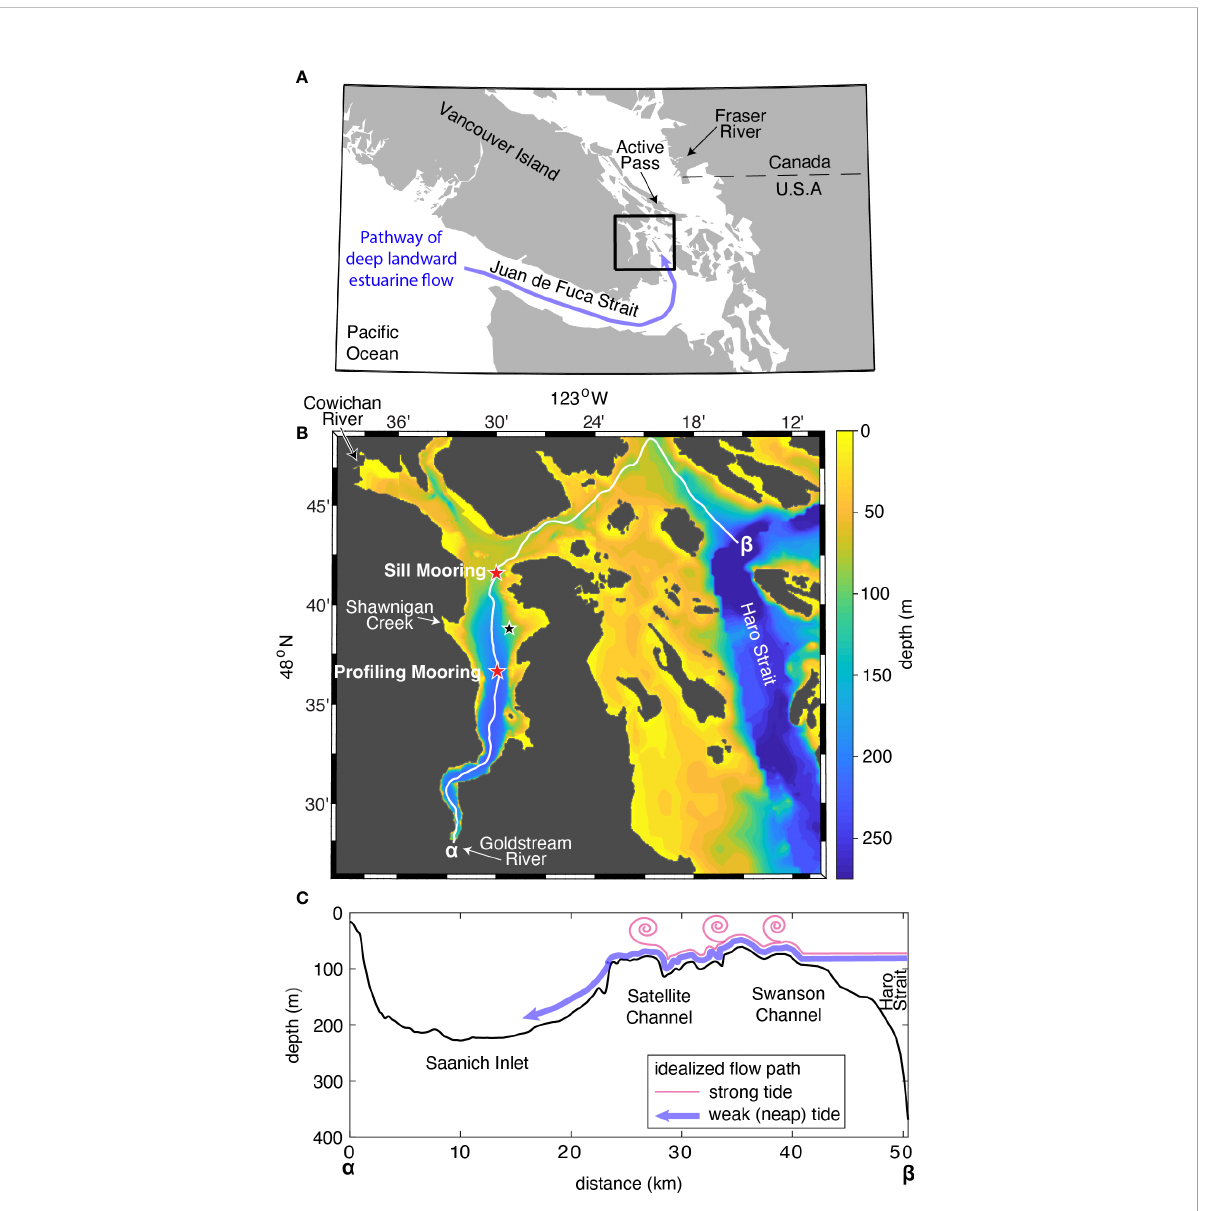
FIGURE 1 (A) Map of Salish Sea region on the west coast of North America. Blue line shows idealized conception of the landward pathway seawater follows in the estuarine system. Black box shows location of next panel. (B) Map of Saanich Inlet and its connection through Satellite Channel and Swanson Channel to Haro Strait. Red stars mark the locations of the sill mooring and pro fi ling mooring. Smaller black star marks the location of a bottom mooring in Patricia Bay. White line marks the location of the deepest part of the channel (thalweg) (C) Cross-section along the thalweg from the southern end of Saanich Inlet ( a , distance 0) to Haro Strait ( b ). Colored lines show idealized conception of bottom water fl owing over the sill during neap tidal current speeds (blue) and higher tidal currents